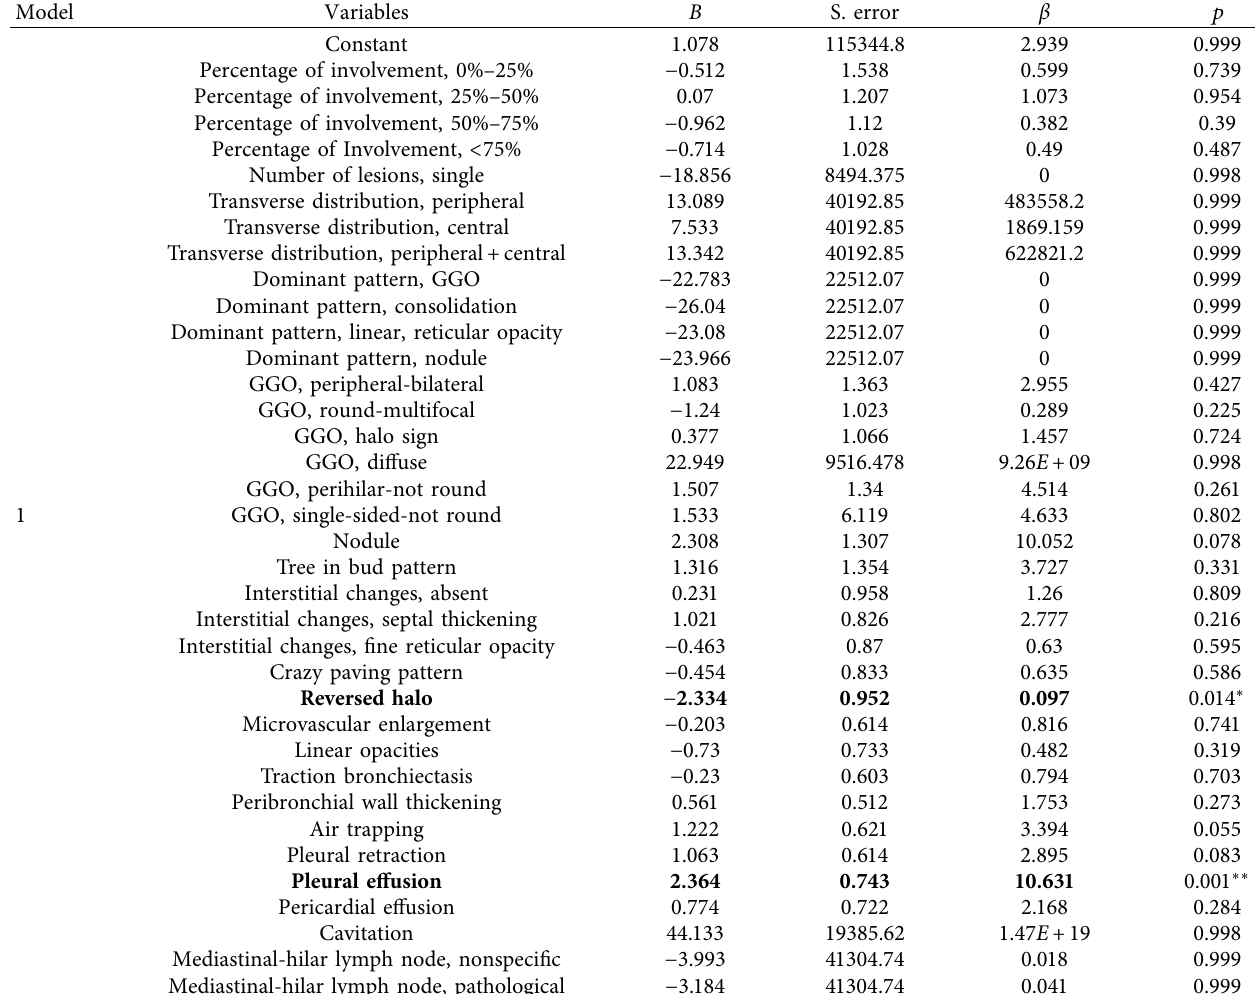
Table 3: Multiple regression analysis findings in relation to independent variables to COVID-19.